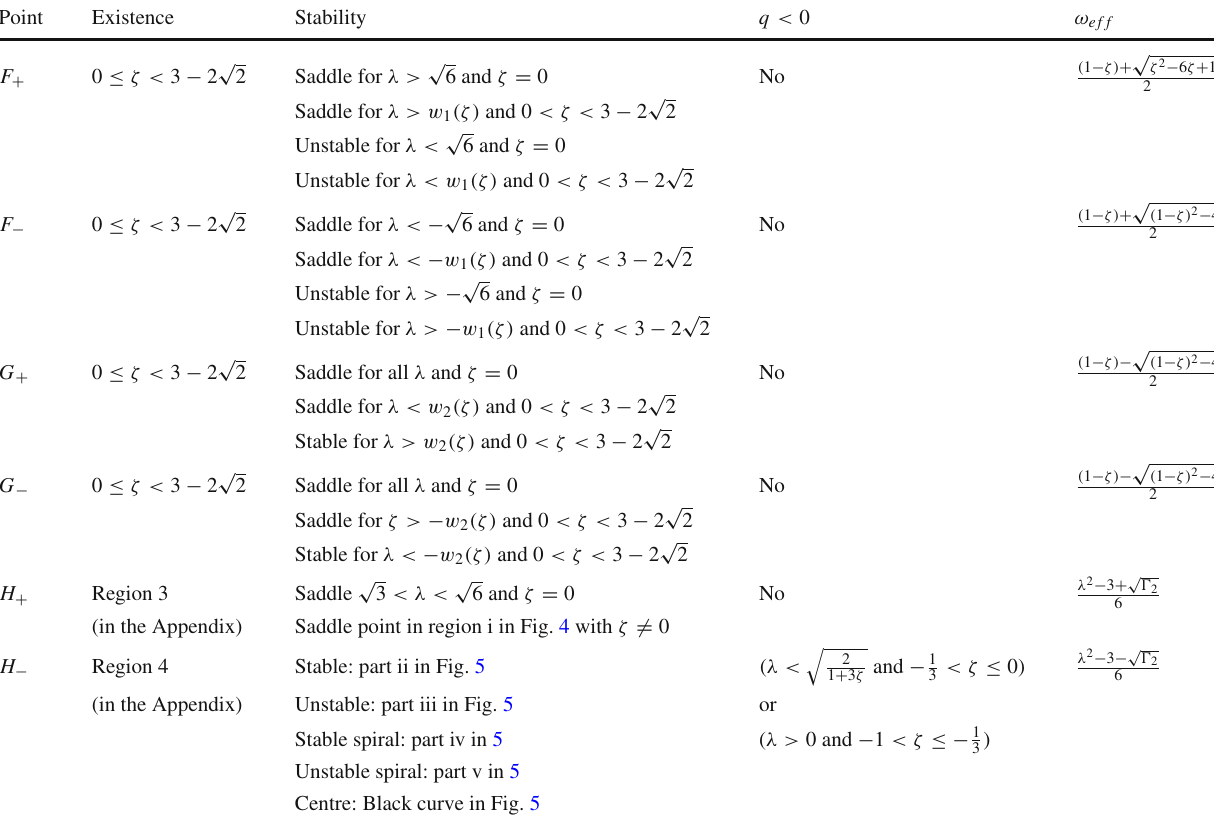
√ ( 1 − ζ) + ζ 2 − 6 ζ + 1 2